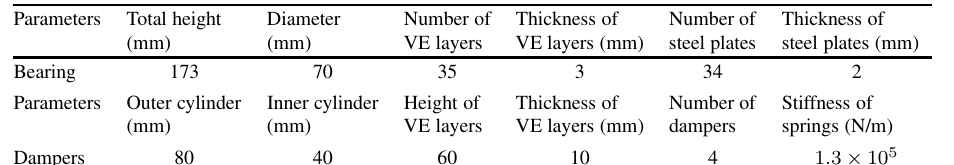
Table 1 The geometric parameters of the tested device